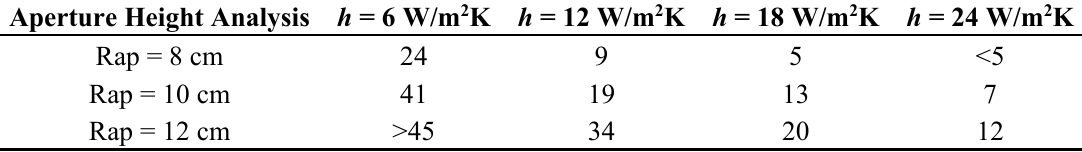
Figure 10. Cavity height variation. Table 2. Optimal aperture height regarding the studied range for aperture